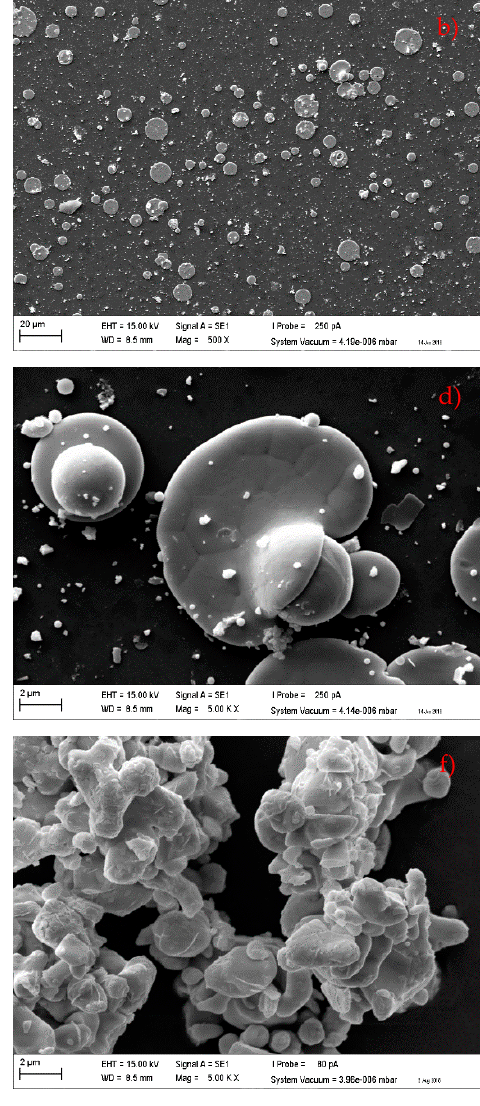
Figure 1 . SEM images of coated borosilicate glass with different magnification ( a ) 100×, ( b ) 500×, ( c ) 2000×, and ( d ) 5000×; Powder reference with different magnification ( e ) 2000× and ( f ) 5000×.